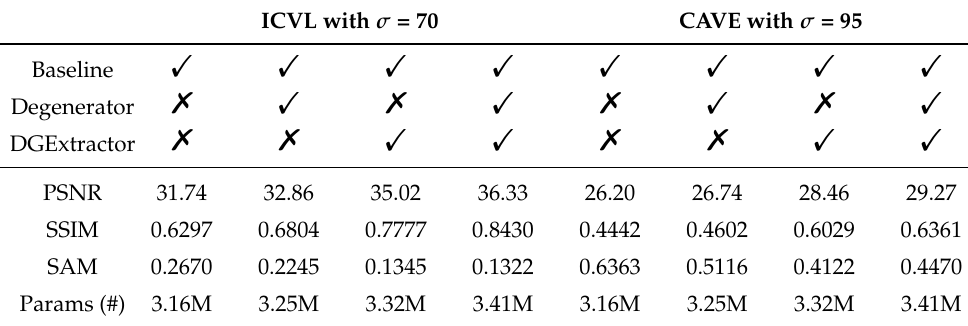
Table 8. Ablation study on DGExtractor and Degenerator . ICVL with σ = 70 CAVE with σ =